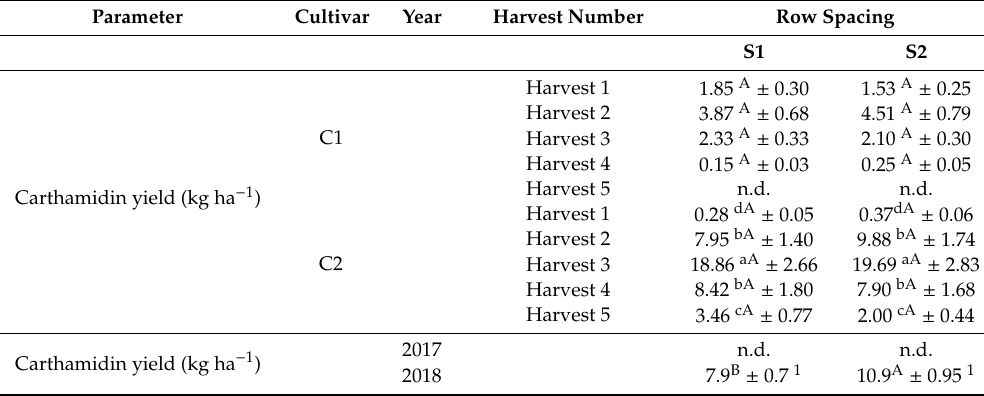
Table A3. Mean values ± standard error and significant di ff erences of the Fisher’s LSD test ( α = 0.05) for the factors cultivar (C1 and C2), year (2017 and 2018), harvest date (Harvest 1–5), and row spacing (S1 and S2). Mean values with at least one identical lowercase letter are not significantly di ff erent between harvest dates (within columns). Mean values with at least one identical capital letter are not significantly di ff erent between row spacing (within